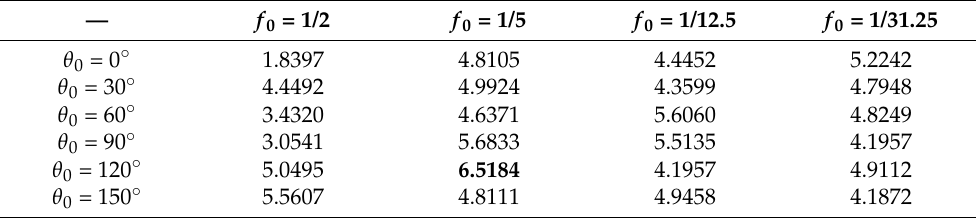
Table 3. The average gradient value of the 24 images after applying the log-Gabor filter. — f 0 = 1/2 f 0 = 1/5 f 0 = 1/12.5